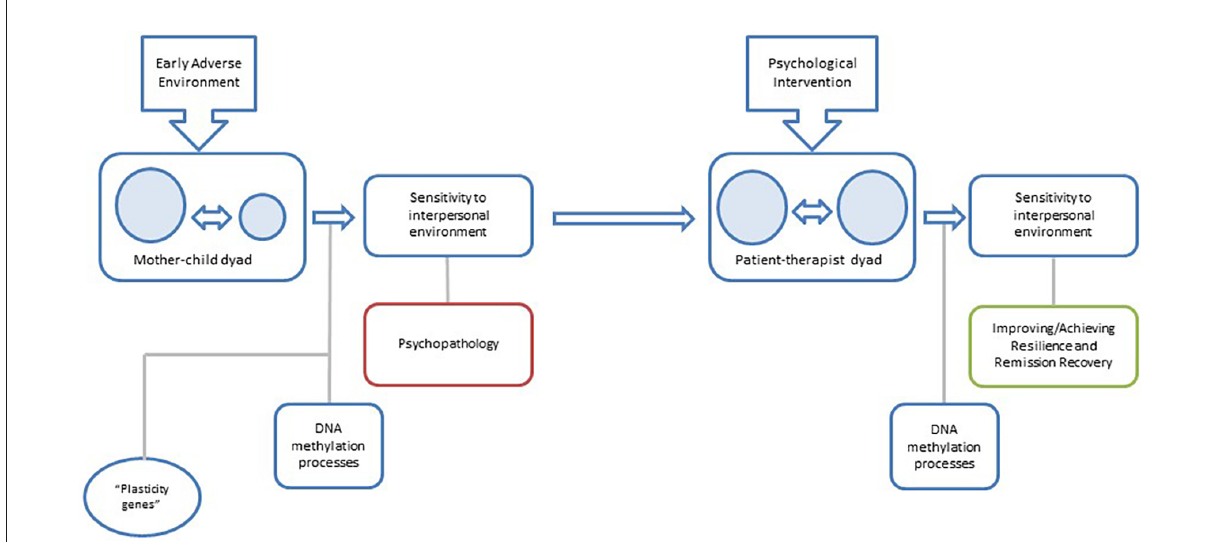
FIGURE1 Proposal for a model of the relationship between changes in DNA methylation and psychotherapy in BPD: early mother-child interaction configures interpersonal sensitivity patterns on the child through DNA methylation processes, and the subsequent development of the borderline phenotype.Inlaterstagesofdevelopment,anappropriatepatient-therapistinteractionwillbeabletoreconfigureinterpersonalsensitivitypatterns and reduce borderline symptomatology through stable changes in DNA